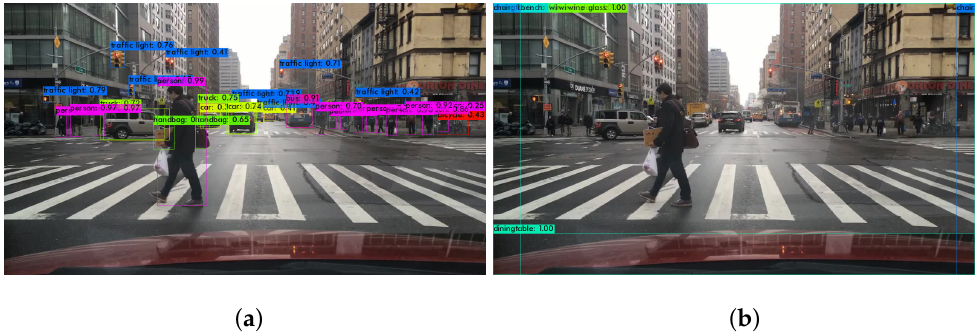
Figure 1. Example of a single-bit error impact in an object detection application based on CNNs. ( a ) Error-free or single-bit error (bit 705) inference; ( b ) Single-bit error (bit 734)